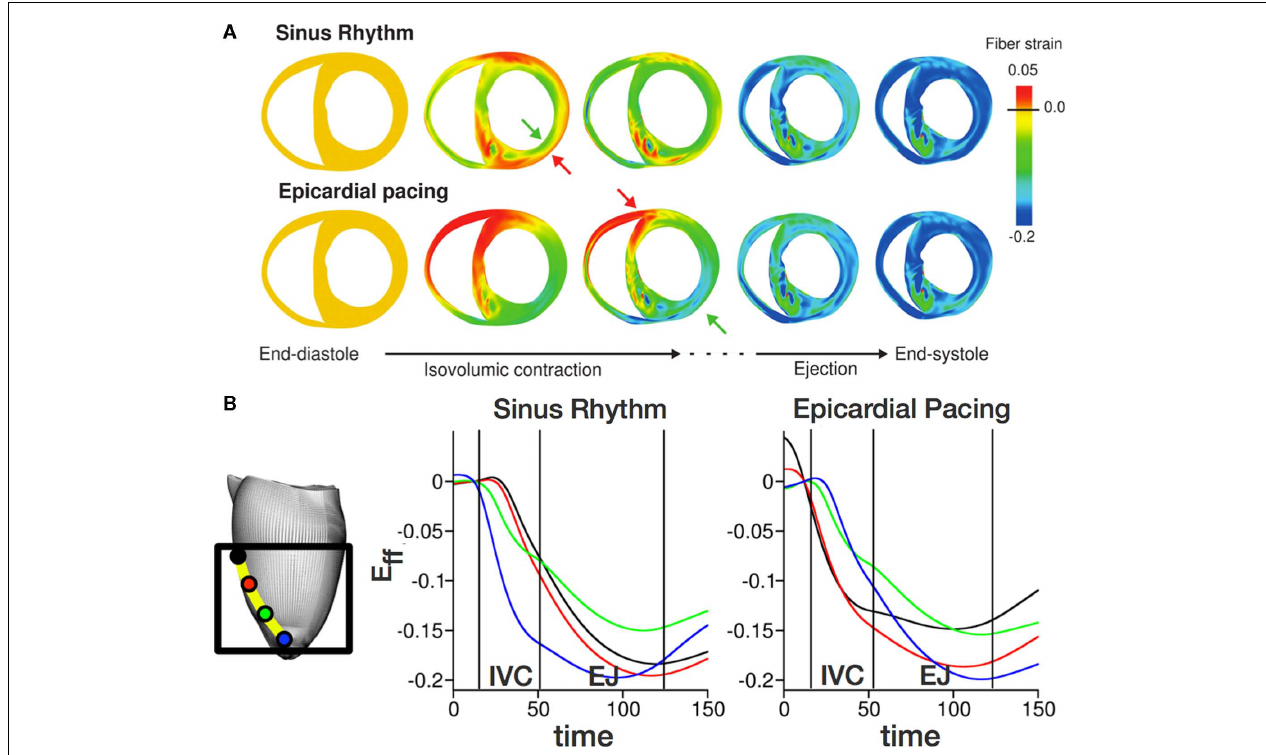
prestretching during the isovolumic phase. (B) Epicardial fiber strain at four epicardial locations. IVC: isovolumic contraction; EJ: ejection. Modified with permission from Gurev et al.